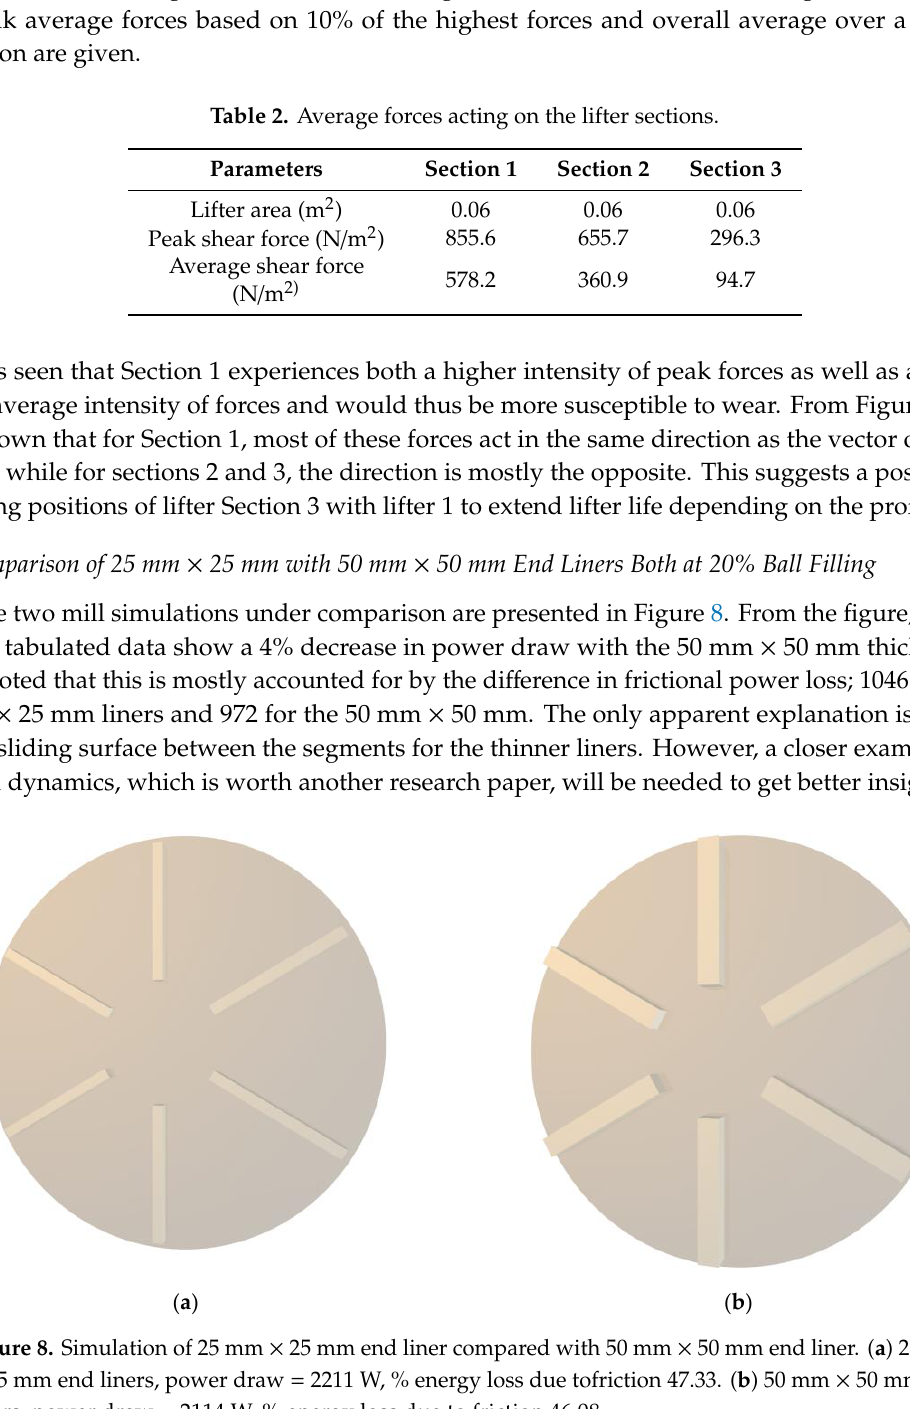
Figure 9. Sectional forces obtained by averaging the forces on all six end lifters (25 mm × 25 mm square liners, 25 mm ball size and 20% ball filling).